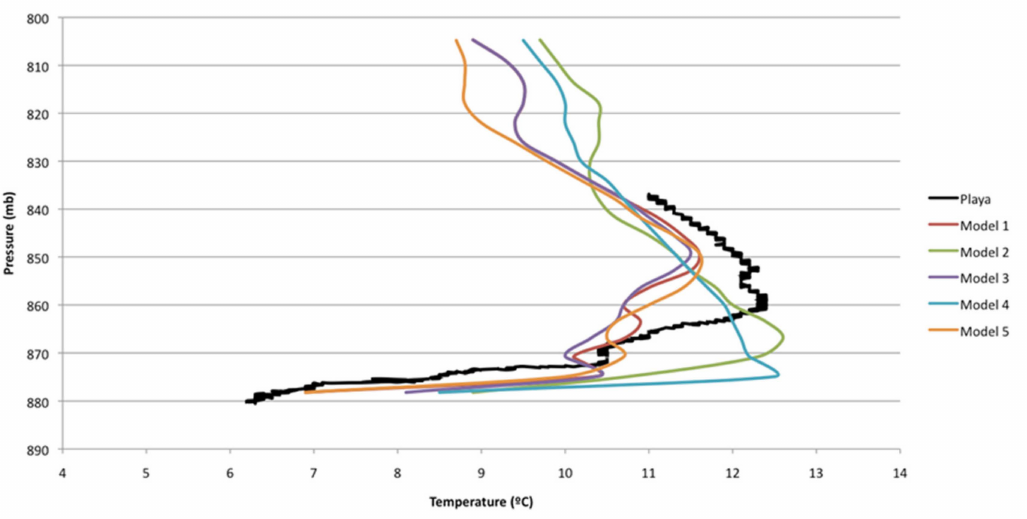
Figure 17. Model upper-air temperature profile ( ◦ C) shown by pressure level (hPa) for different model experiments vs. tethersonde at 1300 UTC 10-14-2012 at the Playa site.